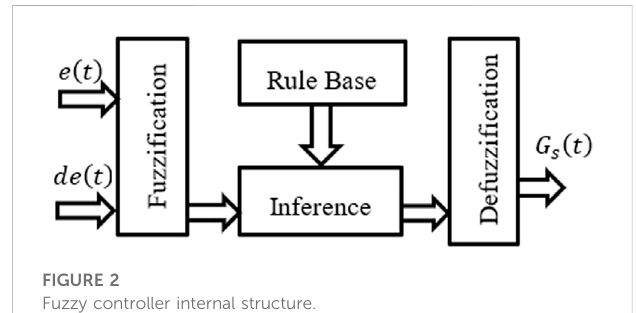
FIGURE 2 Fuzzy controller internal